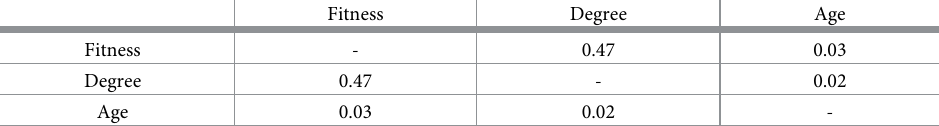
Table 4. Correlation between the fitness, degree, and age for all the nodes in the network by the end of the second (stable) period. We found the correlation between degree and age, and between fitness and age, to be